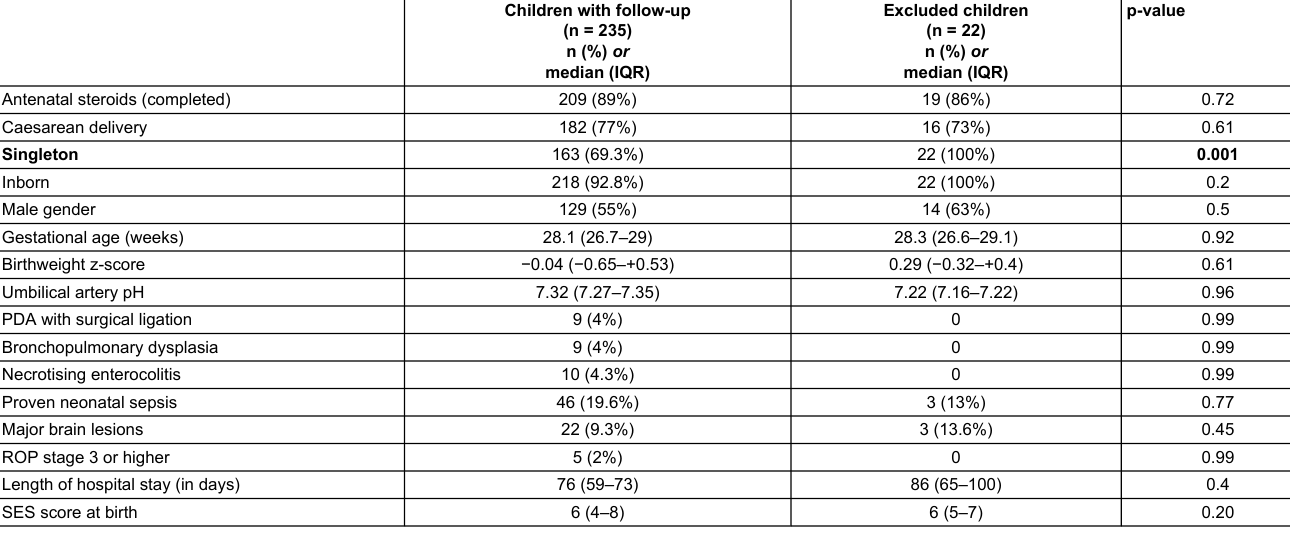
Table S2: Comparison of baseline and neonatal characteristics of children with a follow-up at early school age and children excluded due to the lack of access to the national follow-up program at 5 years of age.